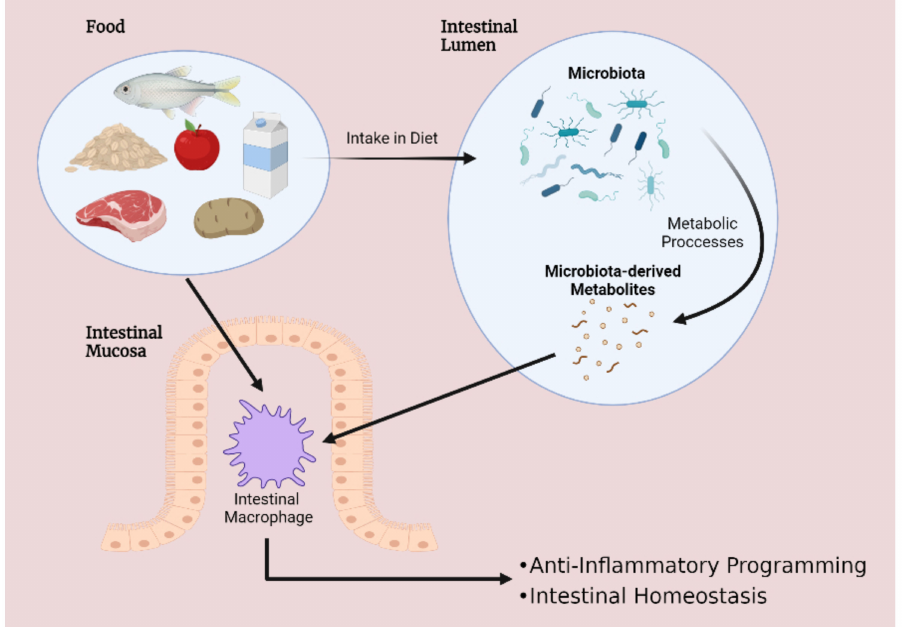
Figure 1. Interplay between diet, microbiota and intestinal macrophages encourages gastrointestinal homeostasis. Disruptions to this delicate balance are implicated in a wide range of disorders— including inflammatory bowel